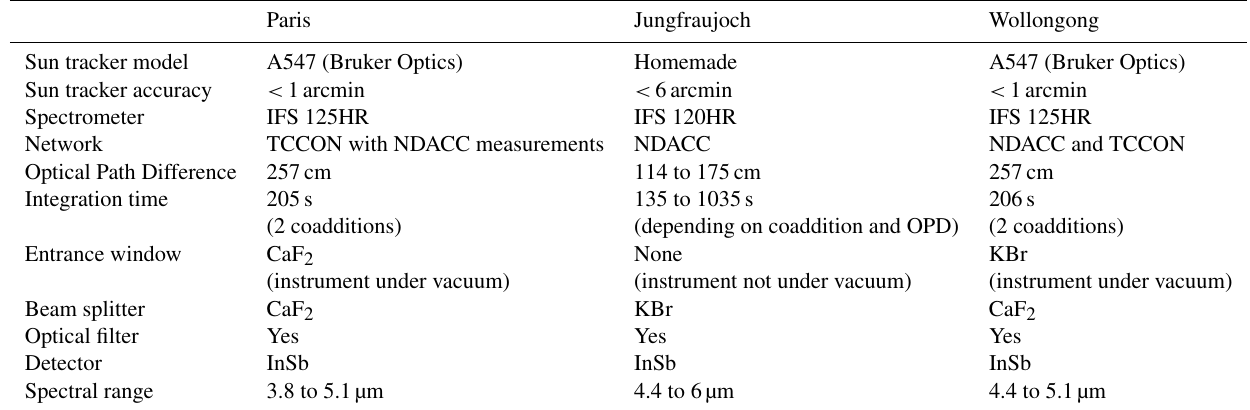
Table 1. Ground-based FTIR instrument parameters for the three measurement